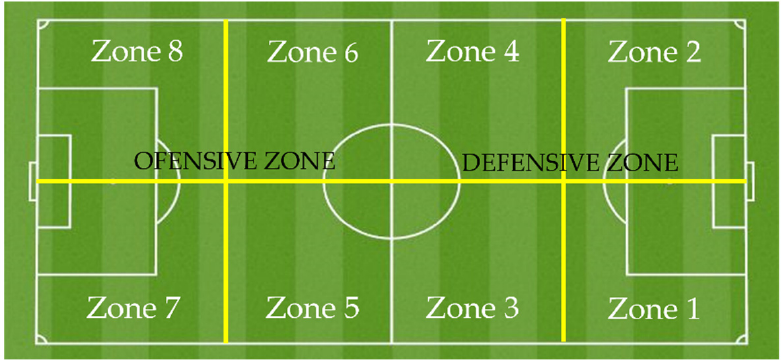
Figure 1. Field zones.